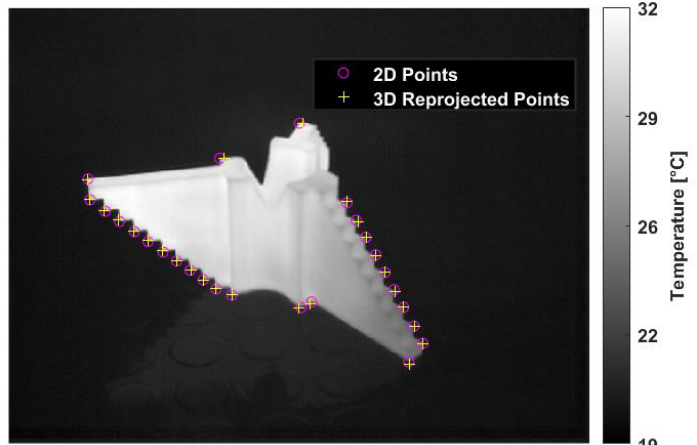
Figure 9. Grayscale thermogram with highlighted the set of 2D points (purple circles) and the reprojection of 3D homologous points (yellow cross) once the extrinsic parameters were computed, in the case of thermogram B of Table 1.